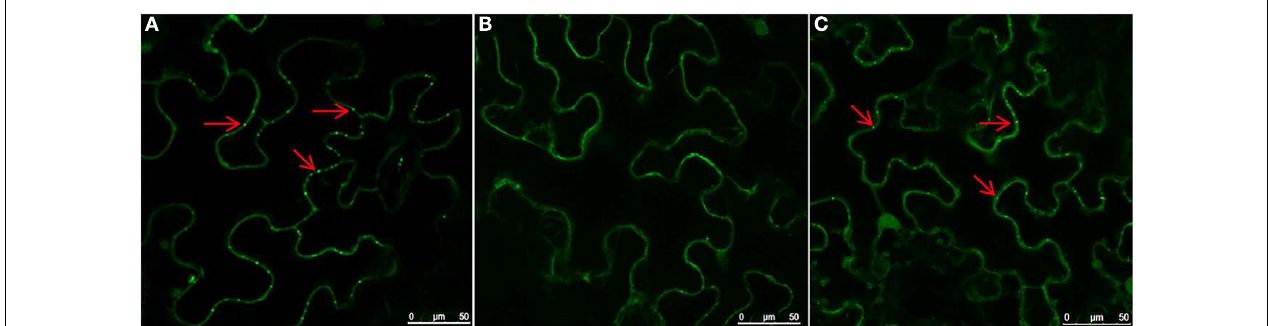
the NSvc4-eGFP vector. Infiltrated leaves were sampled at 48h after agro-infiltration and subjected to examination under the confocal microscopy. Arrows indicate PD localization of fusion